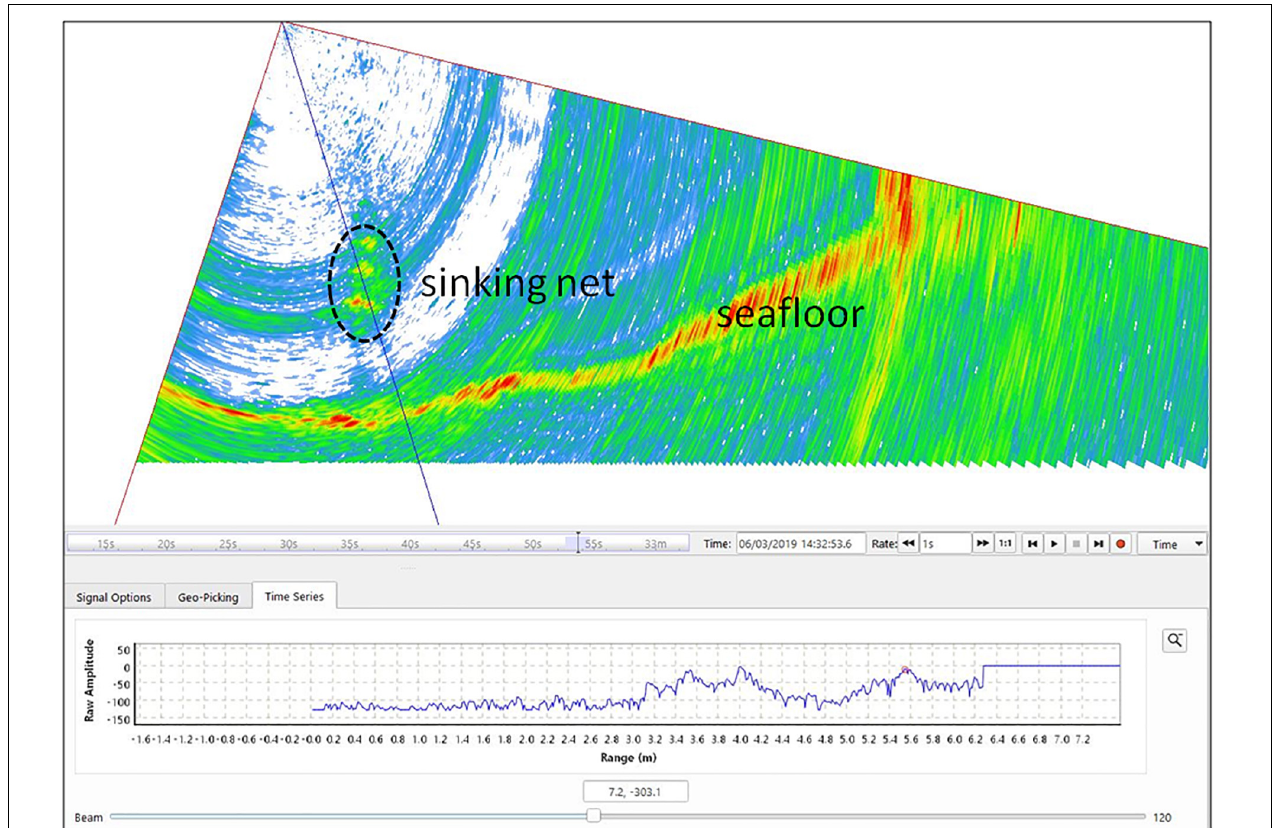
FIGURE 4 | MBES water column data collected to measure the marine litter sinking velocity and acoustic signature and echogram of signal extracted in correspondence of the blue line to identify the sinking net.